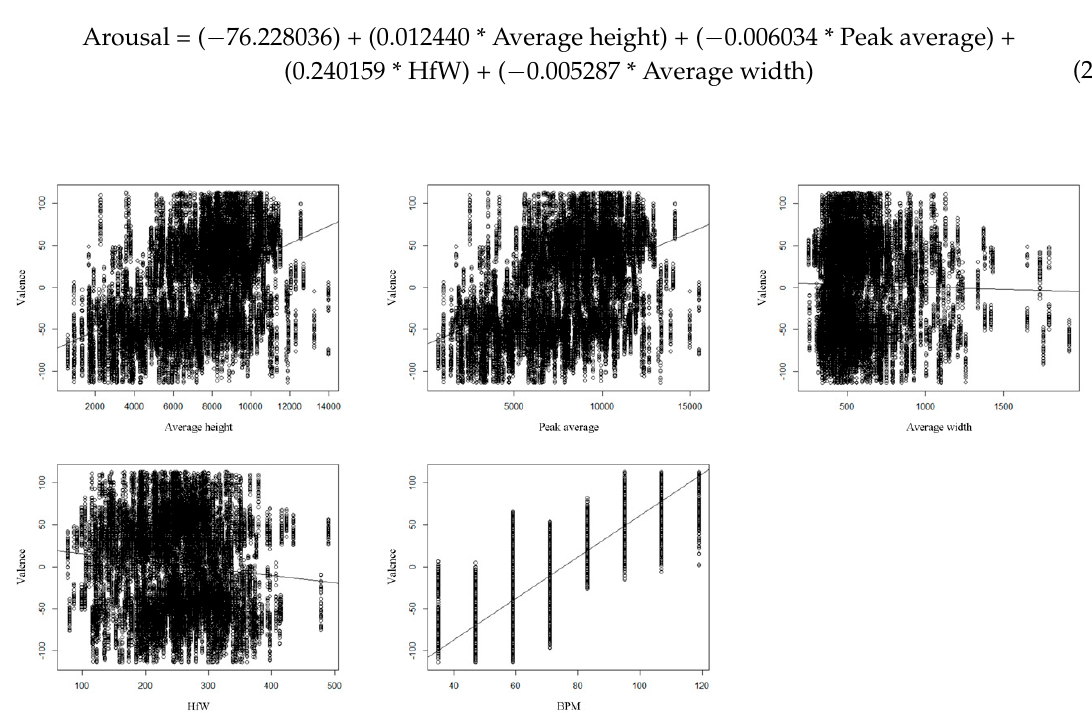
Figure 8. Data distribution for valence with each independent variable.